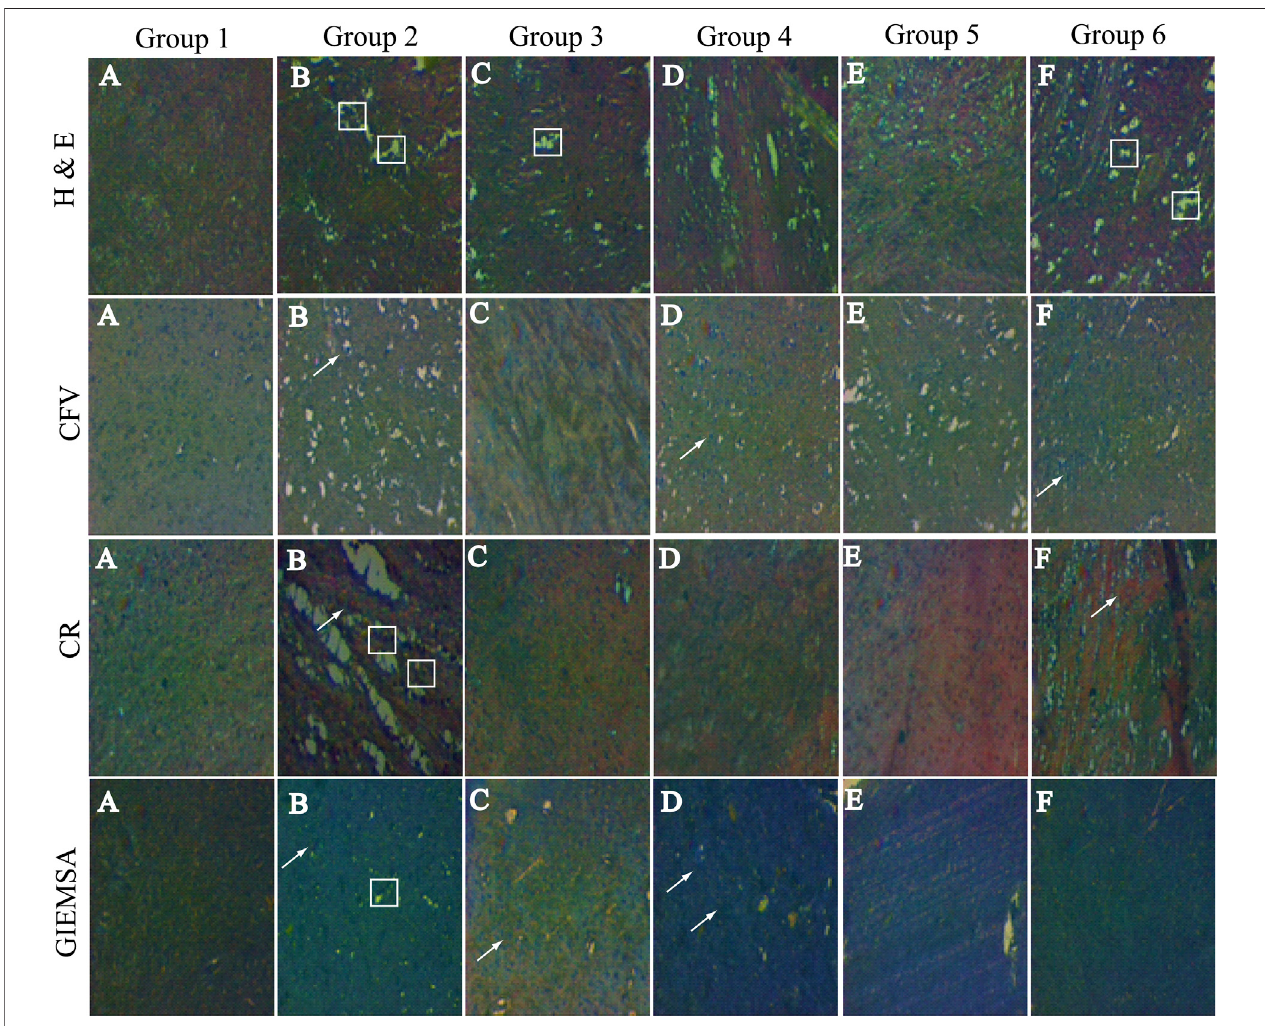
FIGURE 5 | Hematoxylin and eosin staining: Group 1 is showing normal cells in Groups 2, 3, 4, 5, and 6 and displaying the damaged cells. Cresyl fast violet (CFV) staining:Group1Nisslbodiesarenotseen;however,inGroup2,theNisslbodies()arehighlyprominent.Ingroup3thesebodiesarenotseen,inPFtreatedgroupsvery few Nissl bodies are stained. Congo red staining CR: Group 1 neuropils and amyloid bodies are not stained, while in Group 2, neuropils and amyloid bodies ( ) are seen. Neuropils are not seen in any other group; however, F amyloid bodies are stained. Giemsa staining: Group 1 glial cells ( ) are visible. In Group 2, glial cells are not visible, and it contains neuropils. In Groups 2,3,4,5, and 6, glial cells are undamaged.